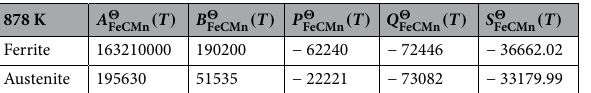
Table 3. Fitting coefficients describing energy contributions ternary Fe–C–Mn phases where A � FeCMn ( T ) and B � T ) respectively denote the second-order terms associated with carbon and manganese, where the FeCMn ( corresponding first-order coefficients are P � FeCMn ( T ) and Q � FeCMn ( T ) 20,46,49 .